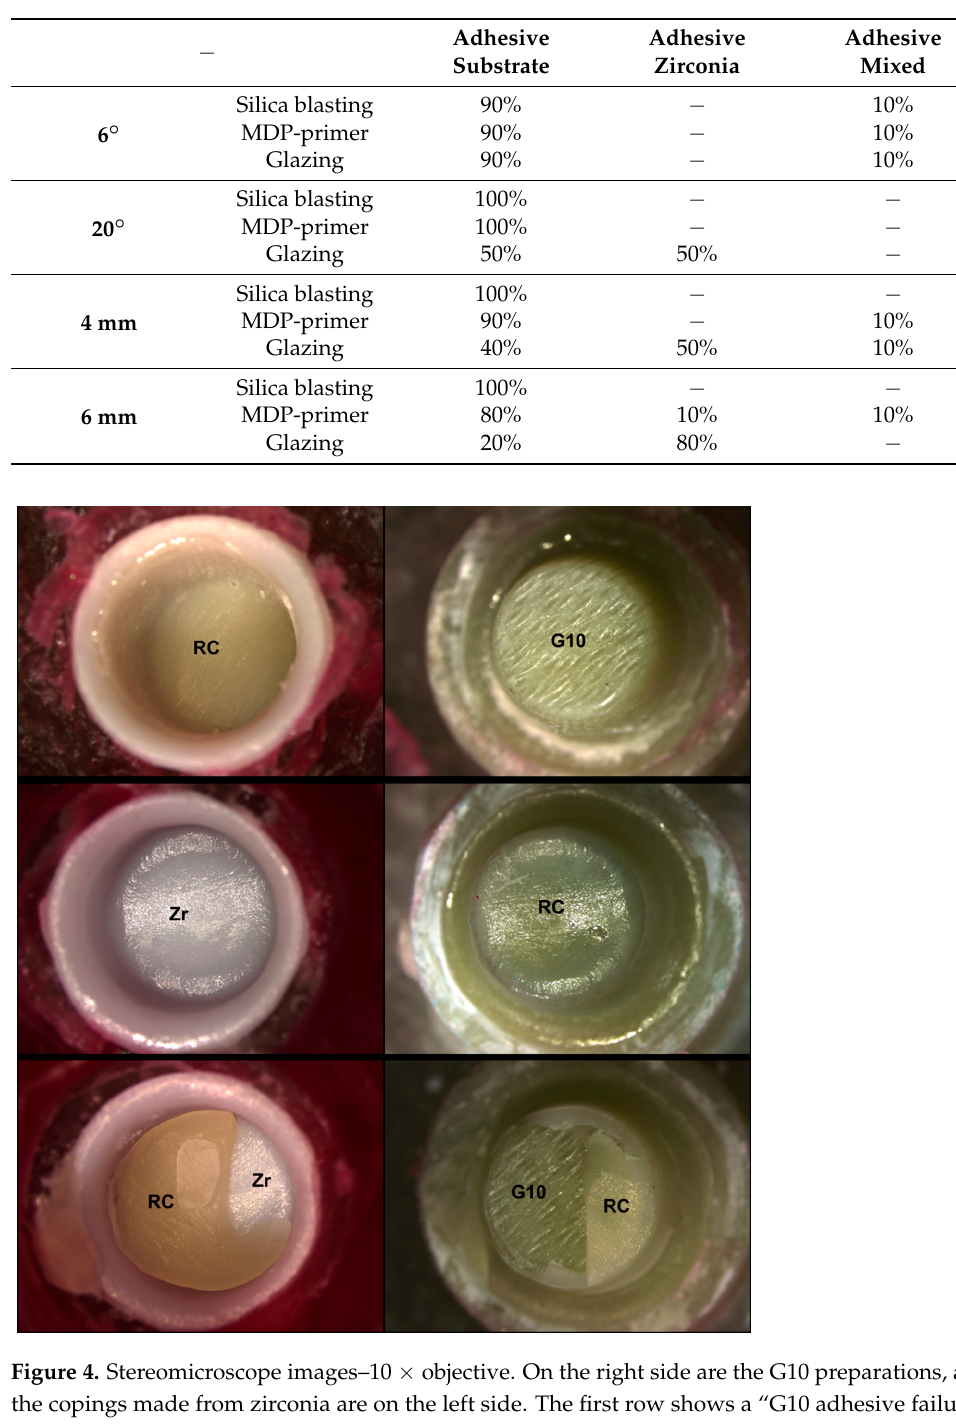
Table 2. Percentage of failures according to the following classification: adhesive substrate (when 50% or more cement was in the coping), adhesive zirconia (when 50% or more cement was in the G10 surface) and adhesive mixed (when there was resin cement in the coping and G10 surface).